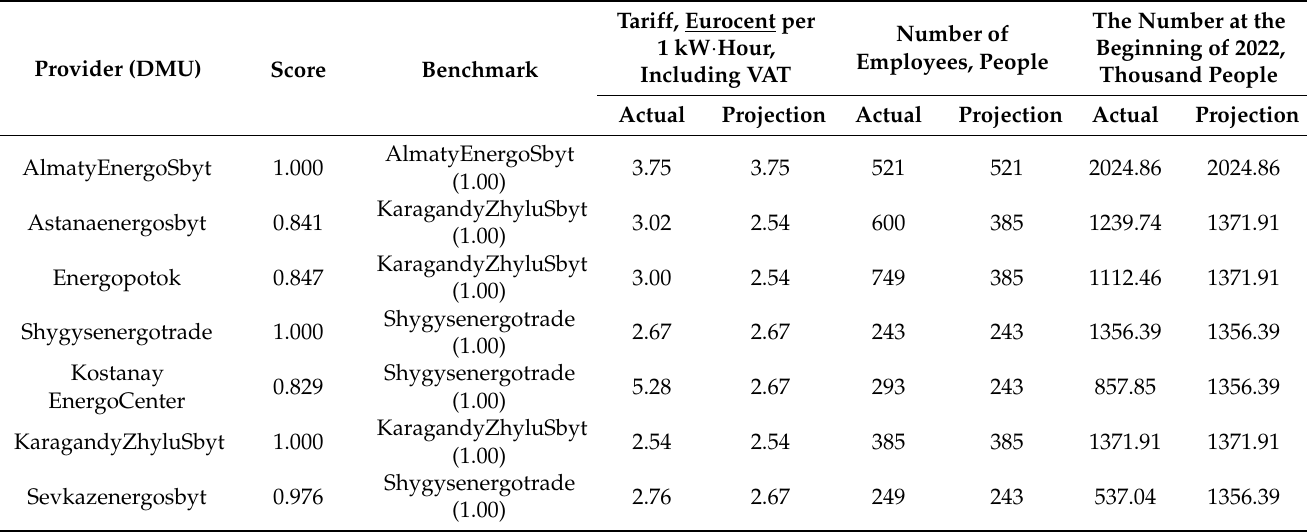
Table 8. Envelopment Model Input-oriented results for 2022’s energy